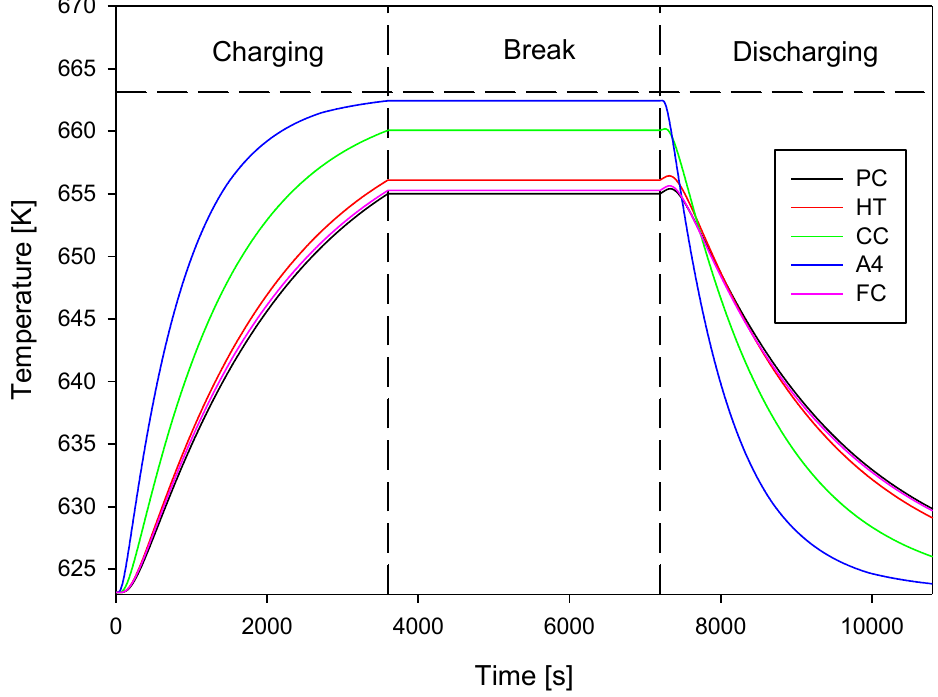
Figure 8. Temperature profile at distance d constant Q nom